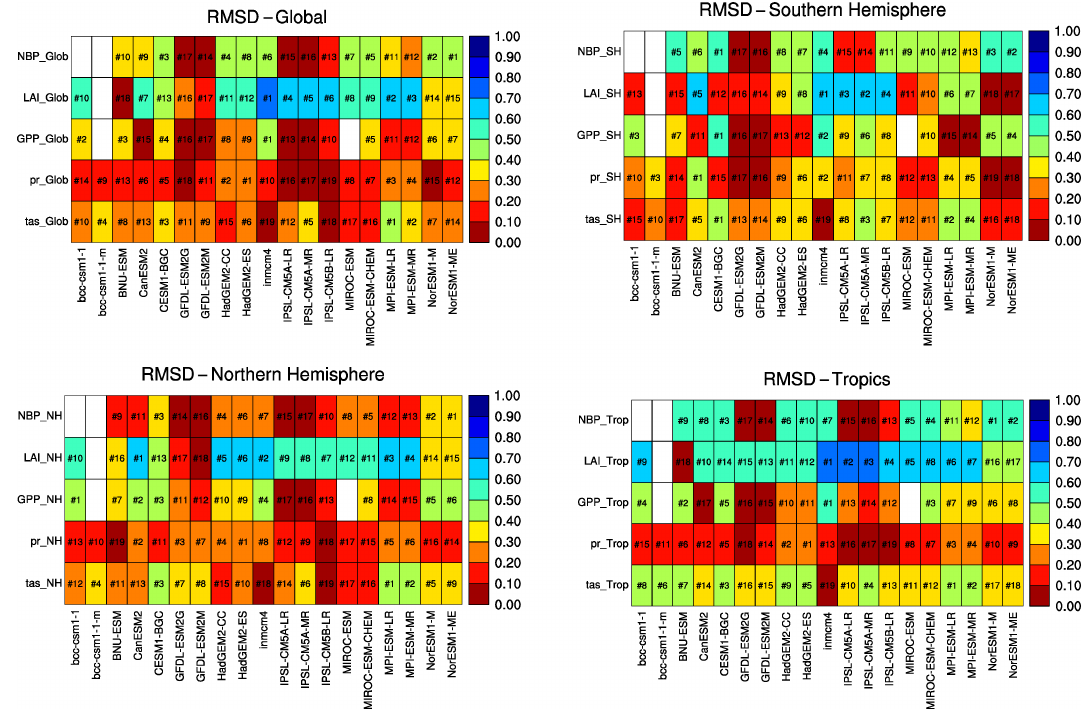
Figure 20. Relative space–time RMSE calculated from the 1986–2005 climatological seasonal cycle of the CMIP5 historical simulations over different sub-domains for net biosphere productivity (nbp), leaf area index (lai), gross primary productivity (gpp), precipitation (pr) and near-surface air temperature (tas). The RMSE has been normalized with the maximum RMSE in order to have a skill score ranging between 0 and 1. A score of 0 indicates poor performance of models reproducing the phase and amplitude of the reference mean annual cycle, while a perfect score is equal to 1. The comparison suggests that there is no clearly superior model for all variables. All models have significant problems in representing some key biogeochemical variables such as nbp and lai, with the largest errors in the tropics mainly because of a too weak seasonality. Similar to Fig. 18 of Anav et al. (2013) and produced with namelist_anav13jclim.xml